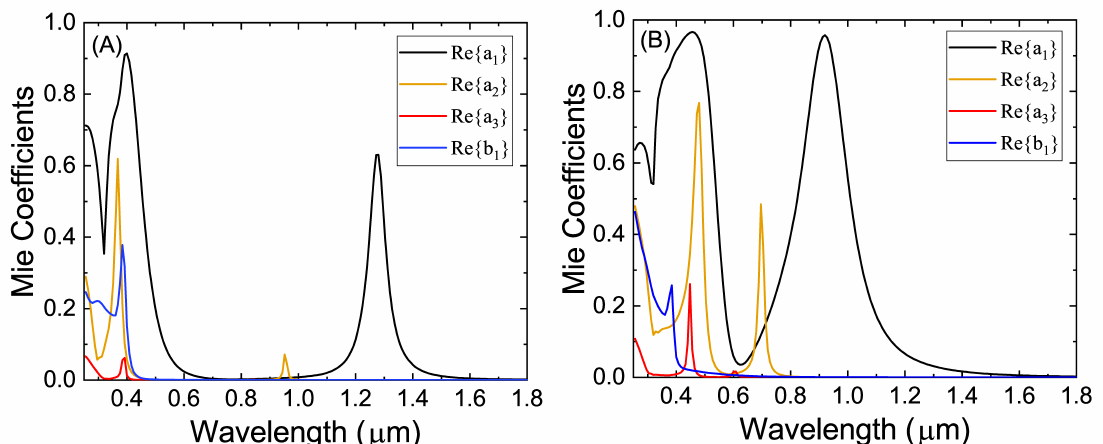
Figure 6. The real part of the Mie coefficients a 1 , a 2 , a 3 , and b 1 for Si@Ag nanoparticles with a core radius of r = 30 nm and total radius of ( A ) R = 35, ( B ) R = 45 nm. The particles are embedded in a medium with a refractive index of